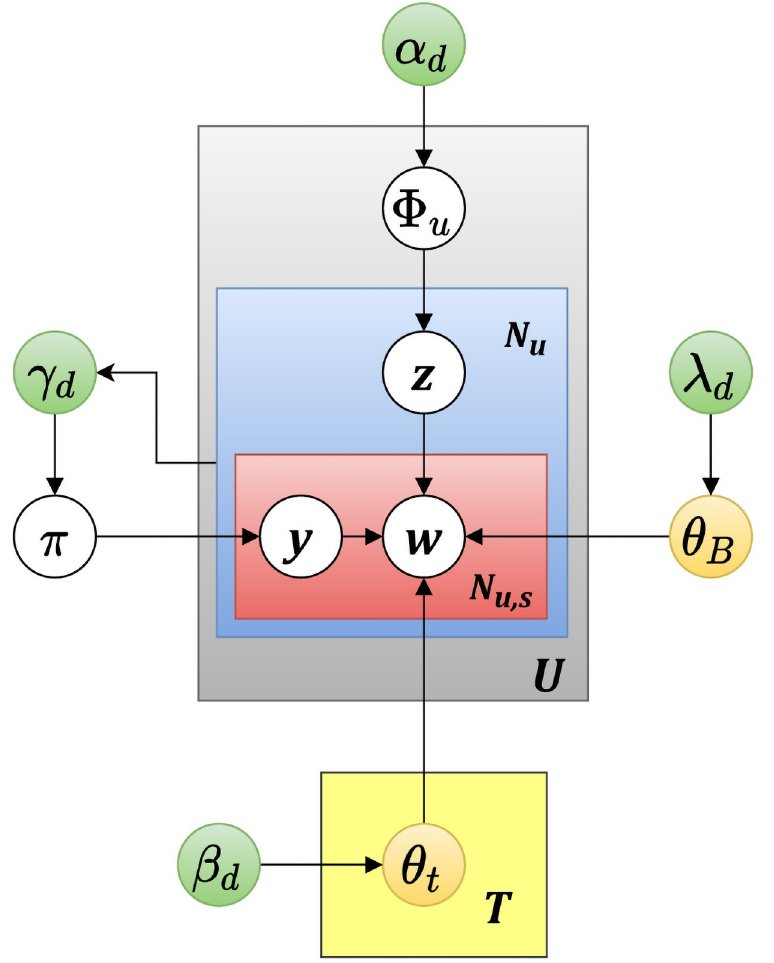
Fig 2. Graphical representation of Twitter-LDA model.